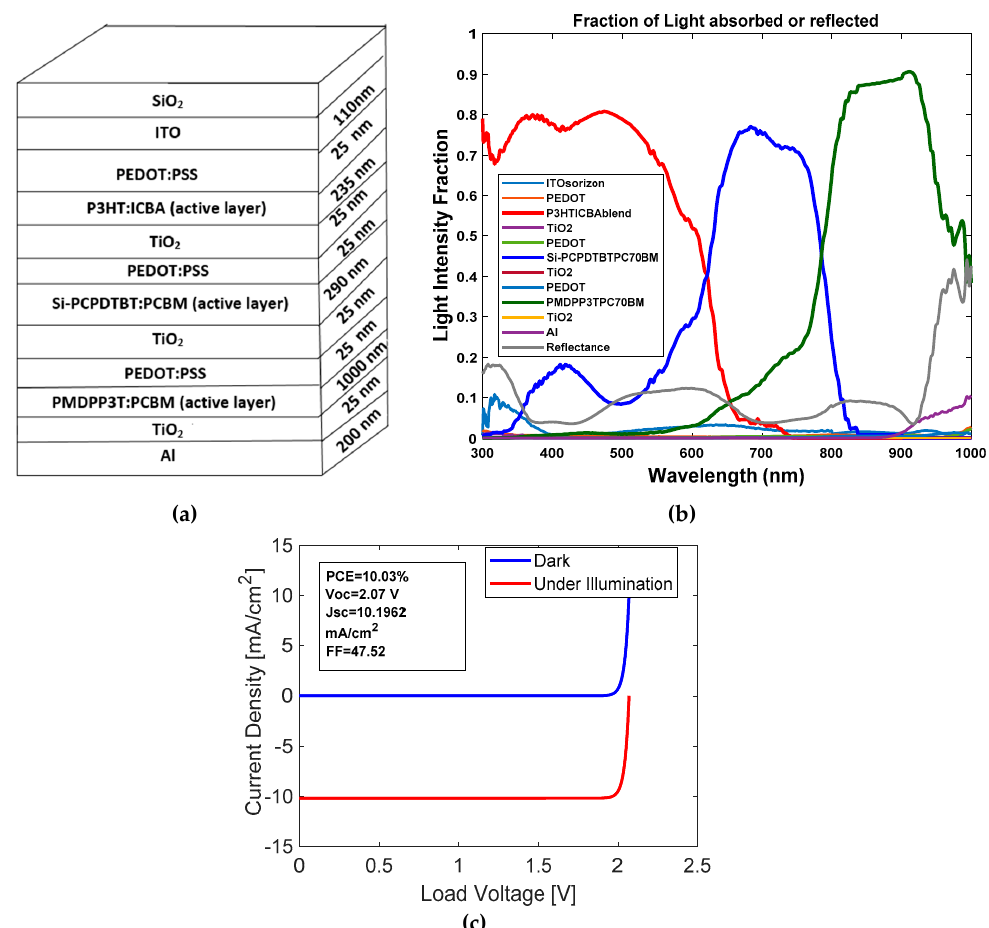
Figure 5. ( a ) Stack diagram; ( b ) variation of light intensity versus wavelength; and ( c ) J–V characteristics for OSC with P3HT:ICBA, Si-PCPDTBT:PCBM and PMDPP3T:PCBM active layers.